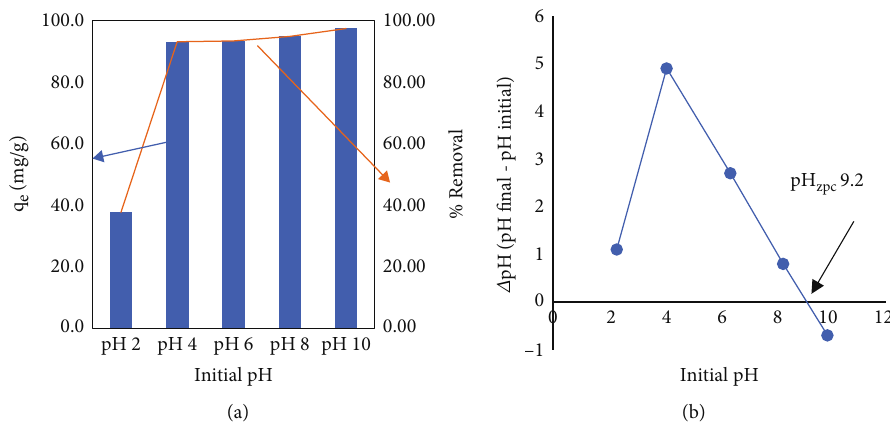
Figure 2: (a) Initial pH e ff ects on MB adsorption capacity and removal percentage. (b) pH zero point charge of ZLCH-b.